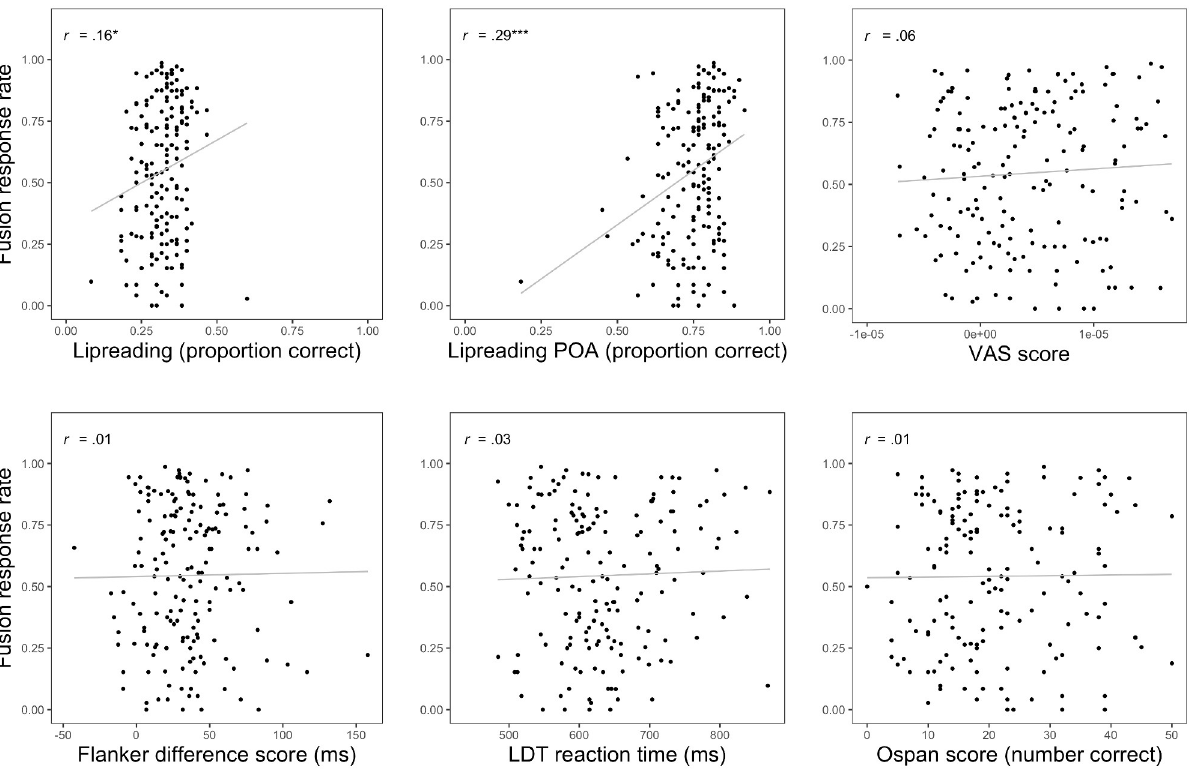
Fig 3. Scatterplot and correlations ( r values; ��� p < .001; � p < .05) showing the relationship between MGS and each of the predictor variables: Lipreading, lipreading place of articulation (POA), perceptual gradiency (visual analogue scale task; VAS), attentional control (flanker), processing speed (lexical decision task; LDT), working memory capacity (operation span; Ospan). Line represents regression line of best fit. Raw VAS scores are shown here whereas centered and scaled scores are shown in Table 2 for ease of interpretation. Note that one participant had a particularly low lipreading POA score and also had a relatively low MGS fusion rate (top row, middle panel). To ensure that this participant’s data were not driving the observed correlation between fusion rate and POA score, we performed an exploratory analysis computing this correlation without that single participant. Results were very similar to those reported in the text ( r = 0.27; p < .001).